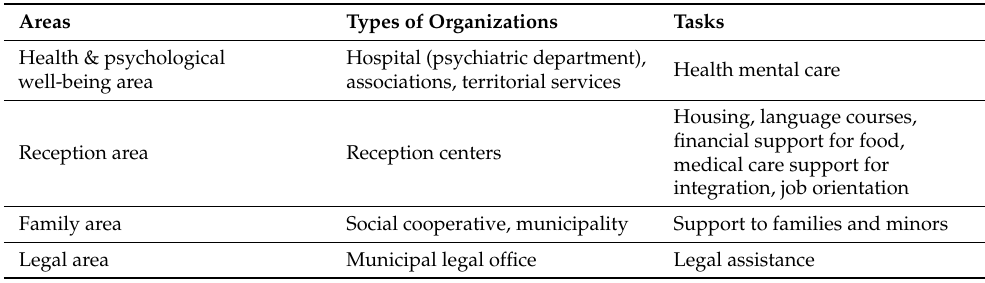
Table 1. Services